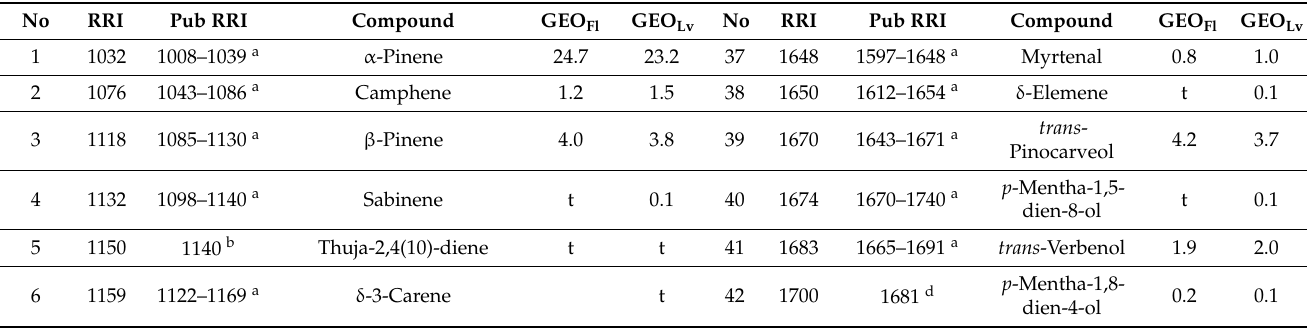
Table 1. Chemical composition of essential oils (%) isolated from flowers (GEO Fl ) and leaves (GEO Lv ) of G. squarrosa